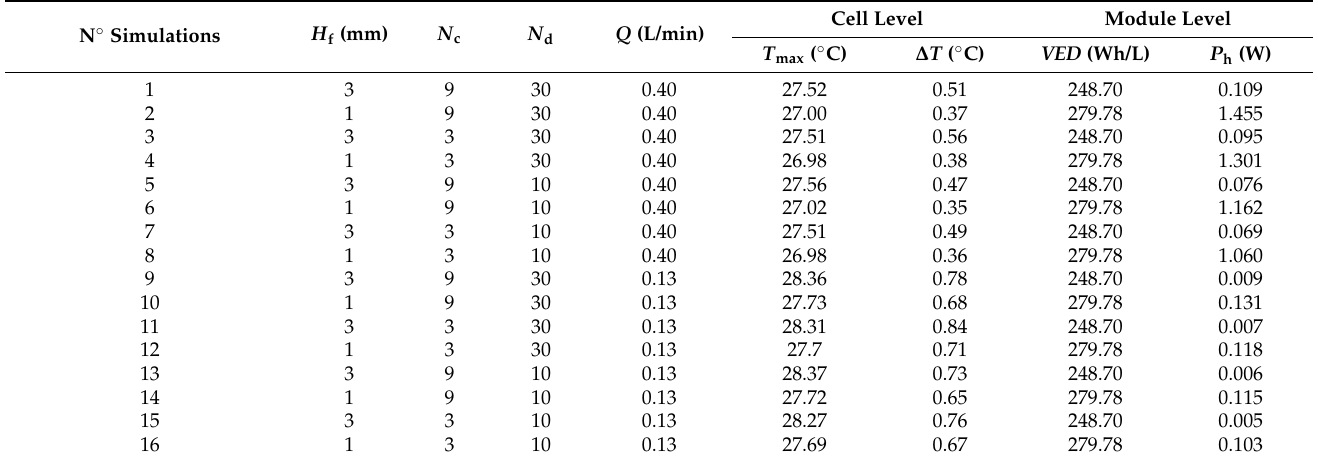
Table 2. The corresponding simulation cases of the two-level full factorial design and the output variable results of each